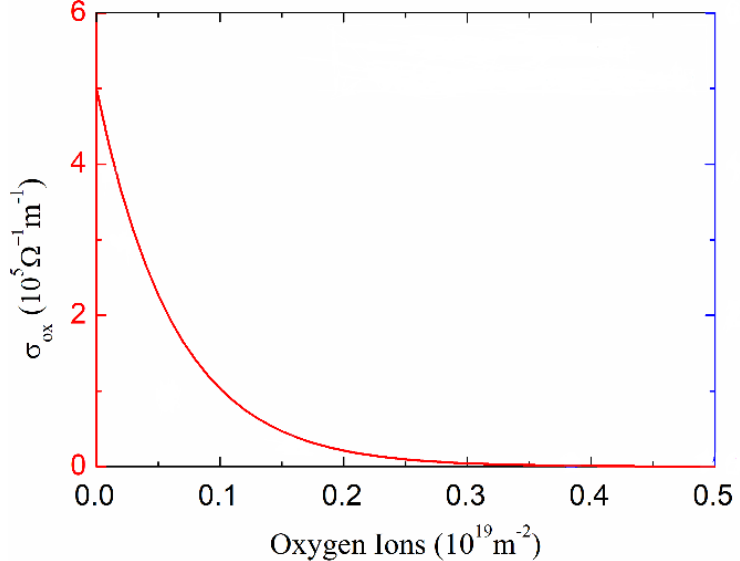
Figure 4. Electrical conductivity model of the partially oxidized graphene oxide [29].